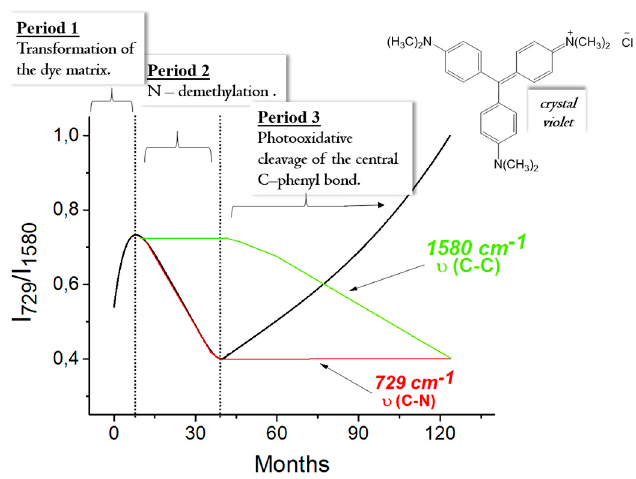
Figure 1. The dependencies of Raman peak intensities ratios plotted for the B-type writing ink at the time when the ink was drawn on paper [16].